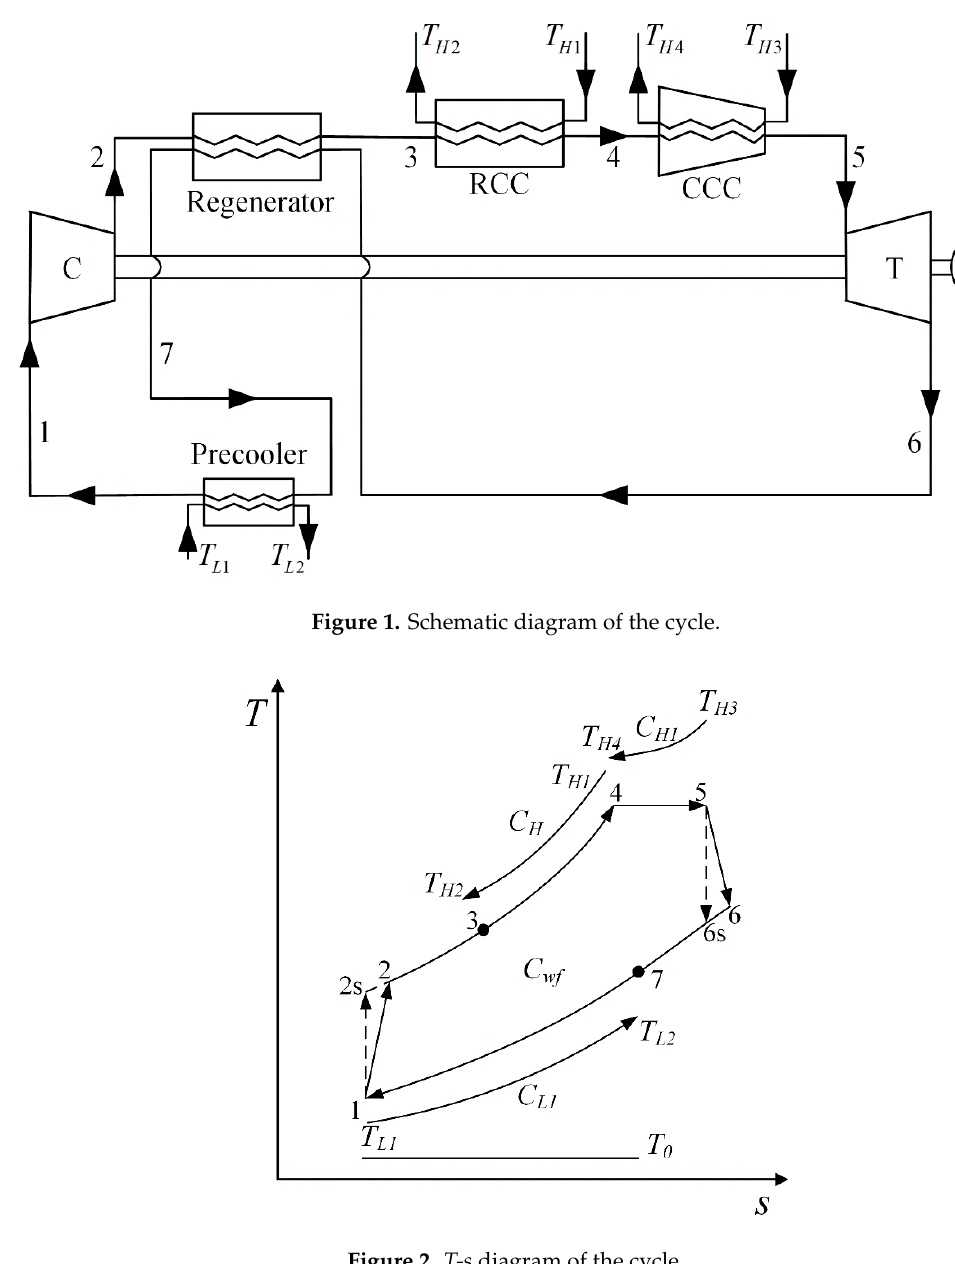
Figure 2. T-s diagram of the cycle.